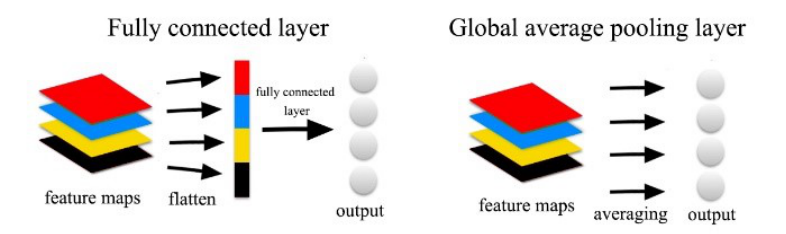
Figure 2. Difference between fully connected layer and global average pooling